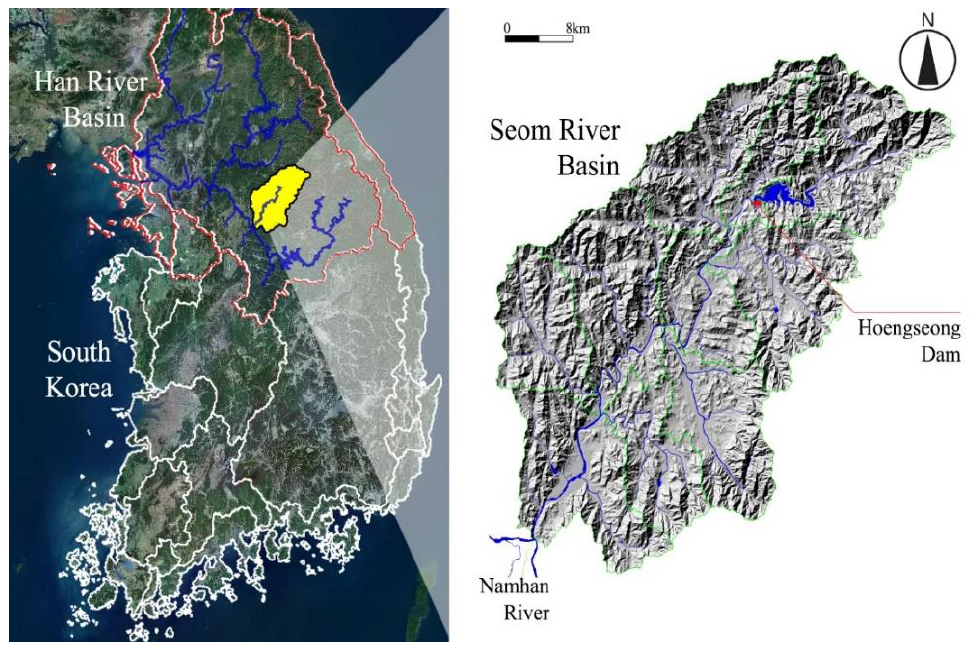
Figure 1. Study Area and basin; red- and whit-line indicate the Han River and other major basins in South Korea respectively, and yellow area indicate the Seom River basin.